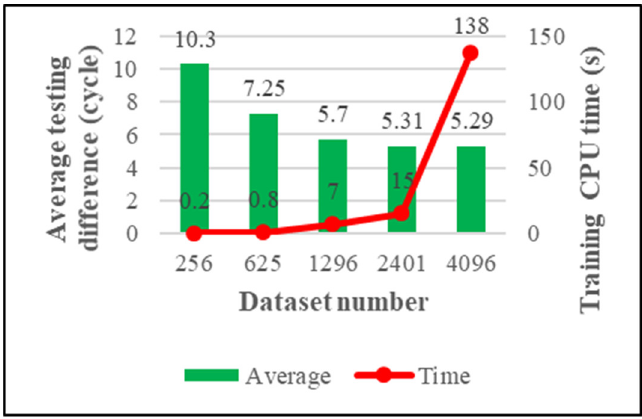
Figure 9. The average testing difference of the KRR model.